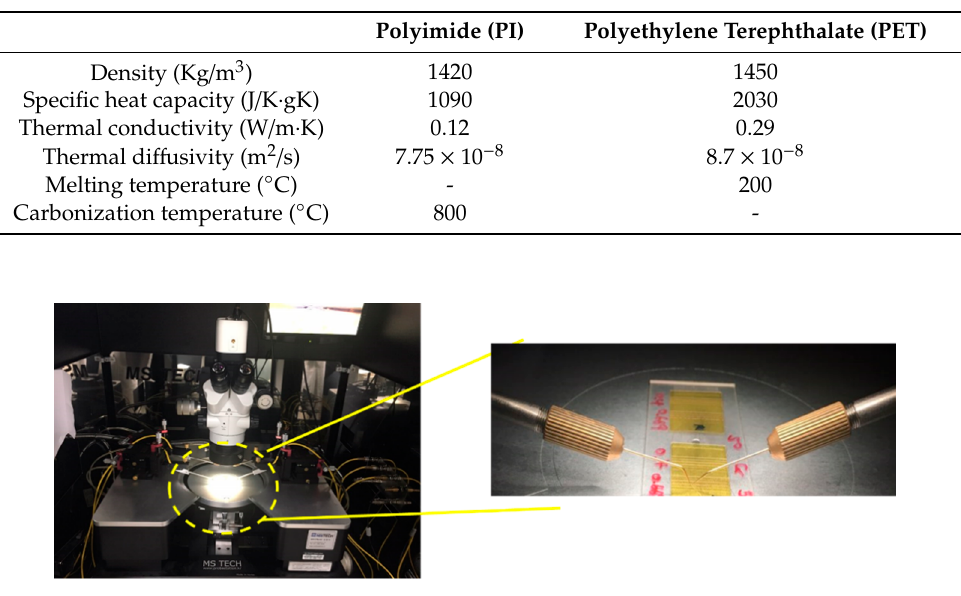
Table 1. Comparison of the physical properties of two polymer materials used in the experiment [41,42].